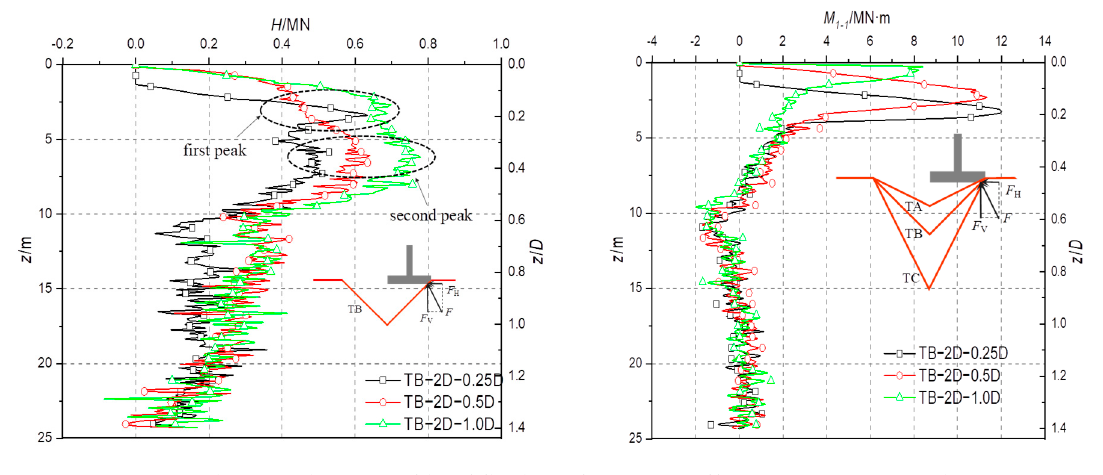
Figure 19. The H and M 1-1 profile of three kind of footings at different offsets.